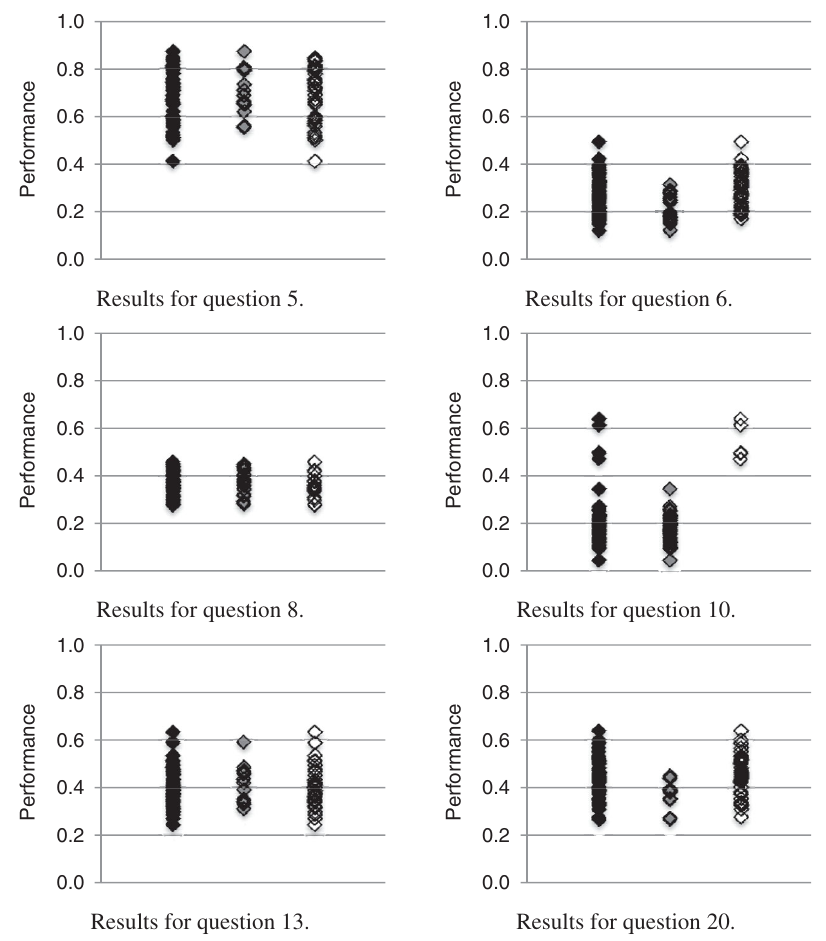
Results for question 13. Results for question 20. FIG. 1. Scatter plots for representative questions (5, 6, 8, 10, 13, and 20 in Table I). Each diamond represents a single class. Black diamonds represent all classes; gray and white diamonds represent classes questioned before lecture instruction and after lecture instruction, points (79 classes), 58 have the label before lecture and 21 have the label after lecture . These data could be shuffled to create 79! = ð 58!21! Þ distinct fictional data sets, in each of which 58 data points will carry the before lecture label while the rest carry the after lecture label. (If the number of combinations is sufficiently large, as it is here, a random sample of them is generated instead.) The difference of the means is calculated for each fictional data set. The percentage of fictional sets in which this difference exceeds that of the actual set can be interpreted as the probability of